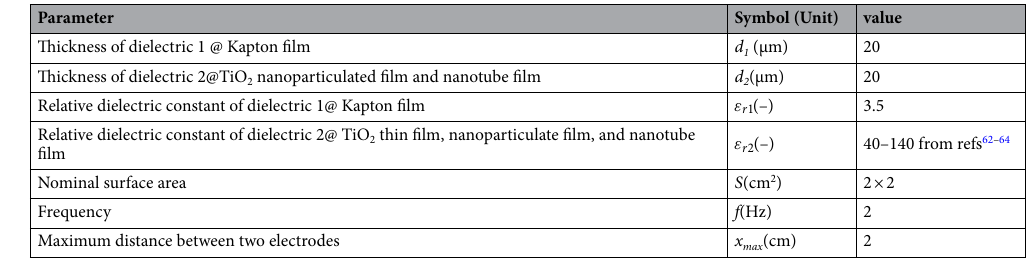
Table 1. The geometrical parameter in numerical